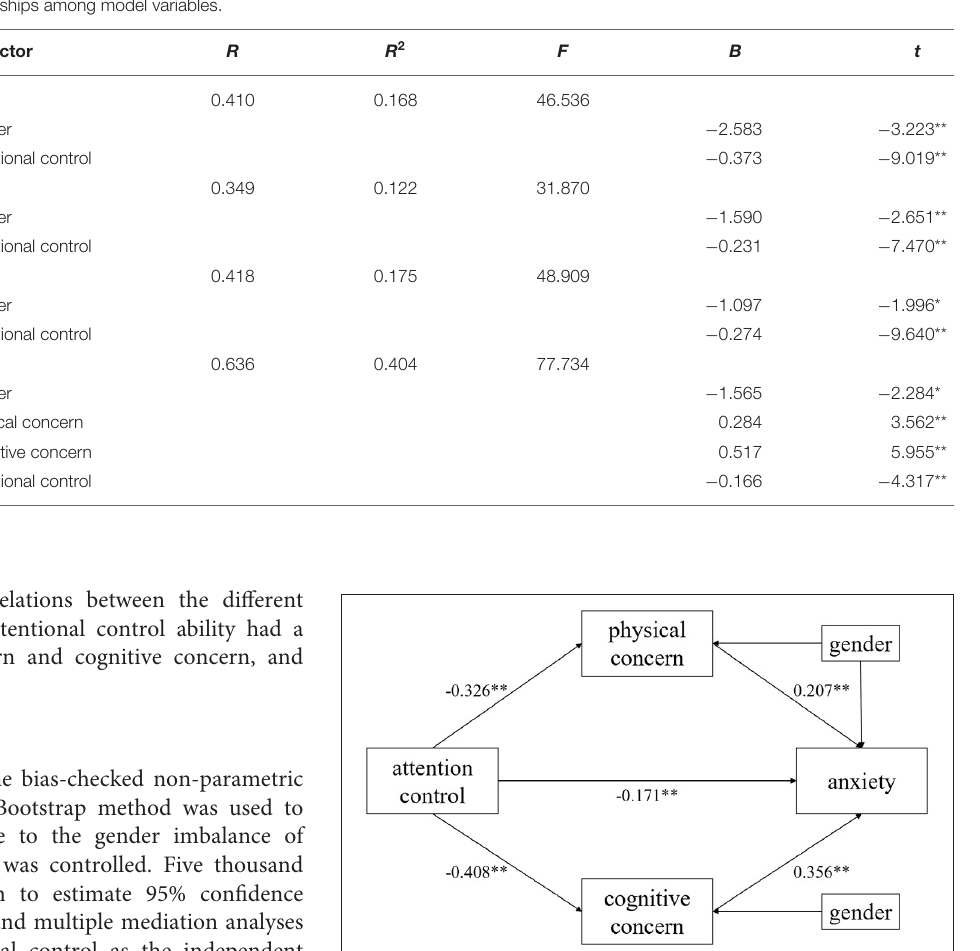
FIGURE 2 | Multiple mediation model. ** p <